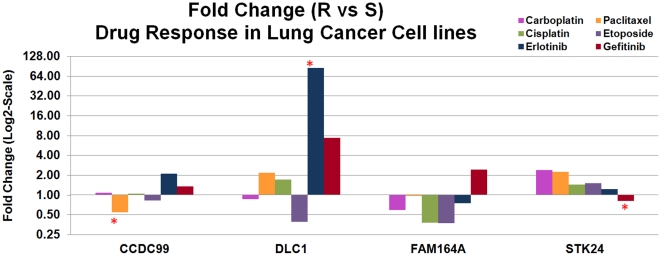
Genes with at least 1.5-fold expression fold change in resistant vs. sensitive lung cancer cell lines to four anticancer drugs.In the graph, differential expression with statistical significance (P<0.05, t-tests) is marked by a red asterisk.